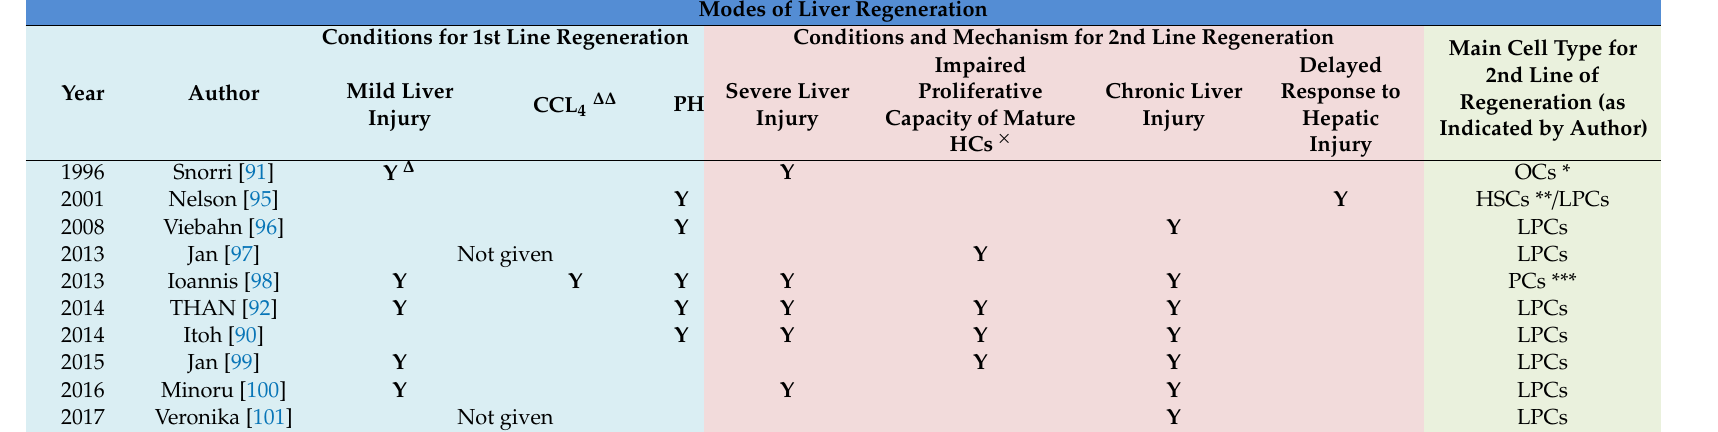
∆ The Y mark (Yes) indicates that the item is selected; ∆∆ CCL4: Carbon Tetrachloride. * OCs (Oval cells); ** HSCs (Hepatic stem cells); *** PCs (Progenitor cells); × HCs: